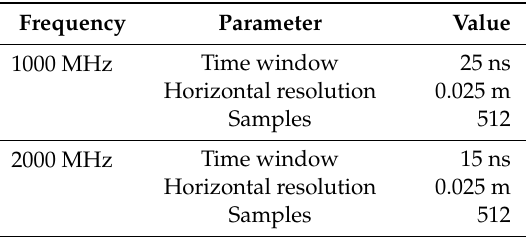
Table 3. GPR acquisition